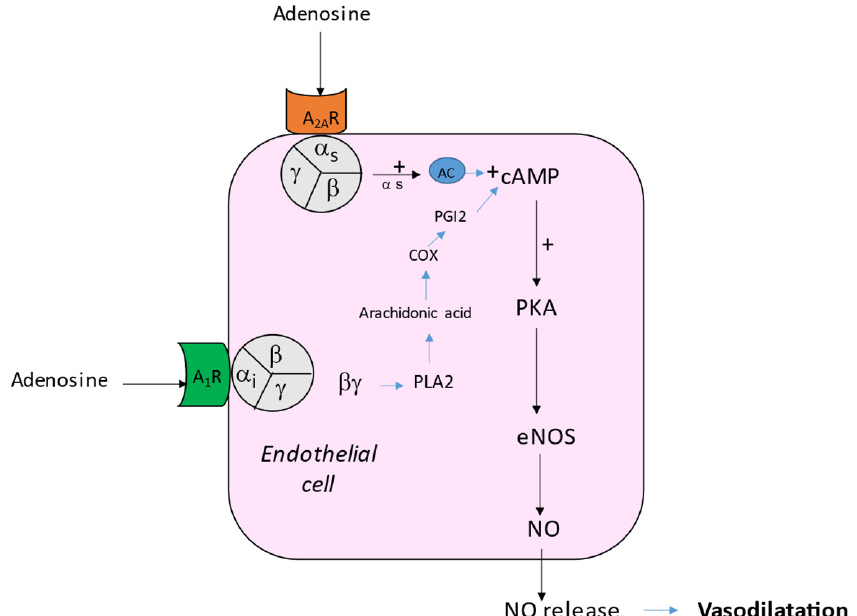
Figure 2. Synergistic effects of A 1 or A 2A R activation on NO release. Adenosine binding to A 2A